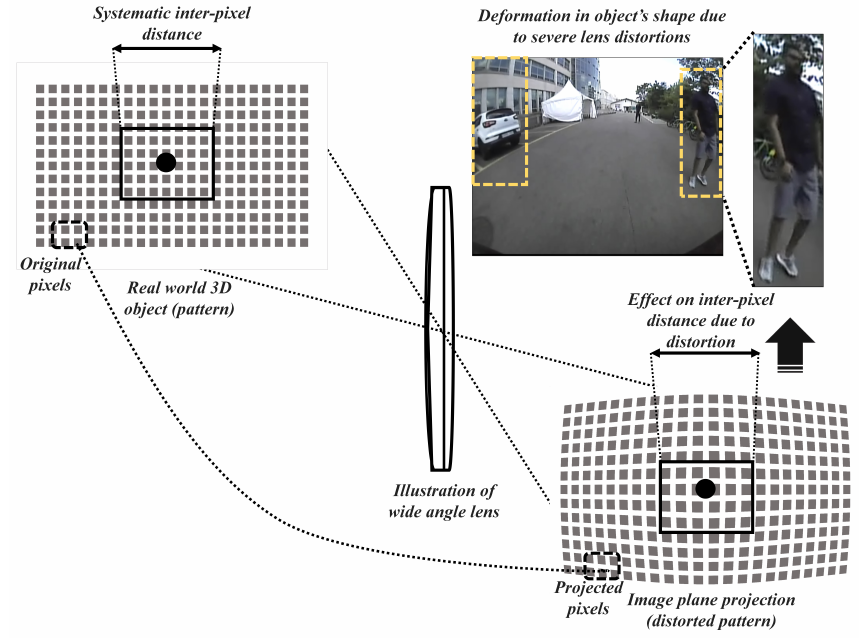
Figure 2. Structural anomaly induced into a scene due to heavy lens distortion caused by wide-angle cameras with field-of-view 120 ◦ < FOV < 140 ◦